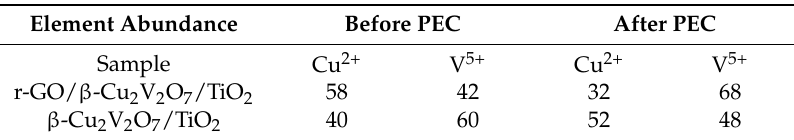
Table 1. Cu and V percent abundance from XPS